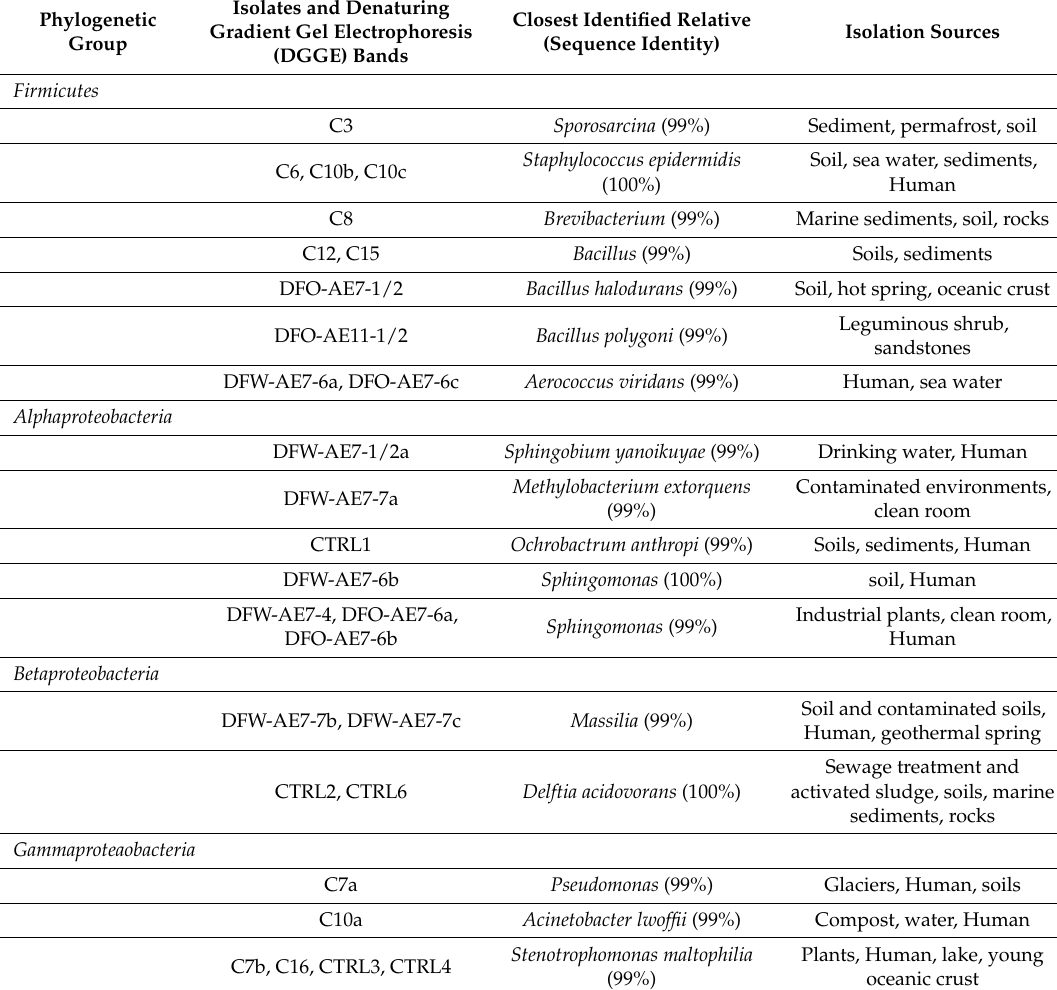
Table 3. Distribution of contaminant phylotypes that were identified within control